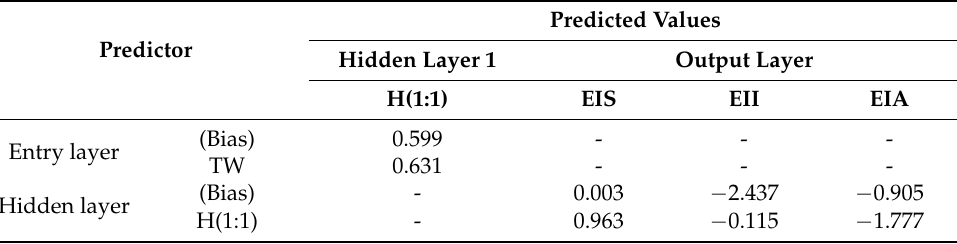
Table 4. The values of the multilayer perceptron model concerning telework (T.W.) and employment by sectors (E.I.S., E.I.I., E.I.A.).